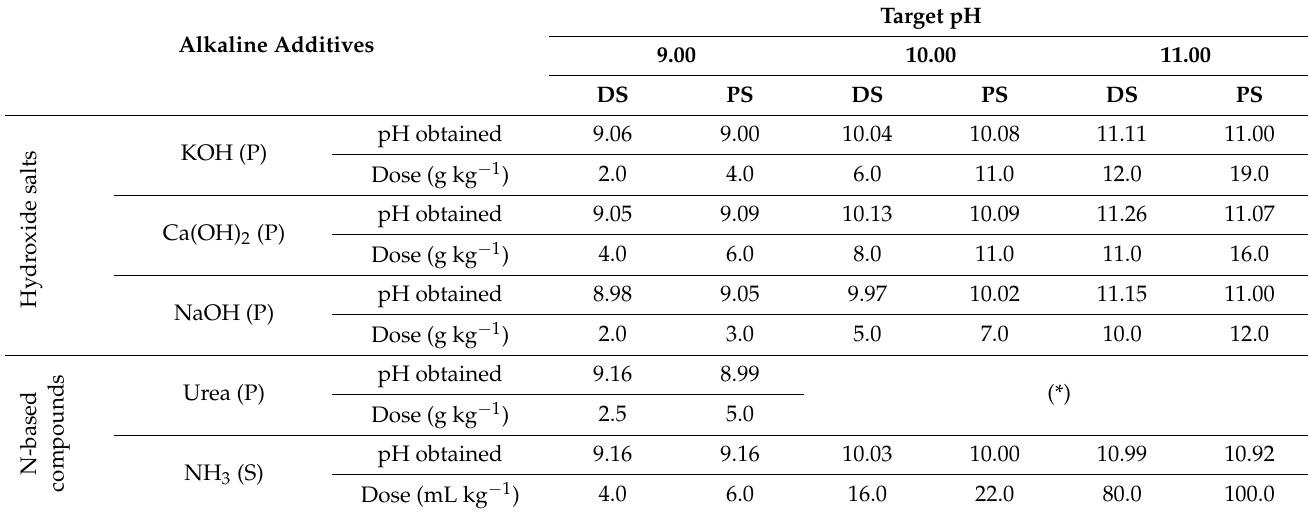
Table 2. Doses of potassium hydroxide (KOH), calcium hydroxide (Ca(OH) 2 ), sodium hydroxide (NaOH), urea ((NH 2 ) 2 CO) (g kg − 1 ), and aqueous ammonia, NH 3 (mL kg − 1 ) necessary to increase the pH of dairy and pig slurries to the target pH values (9.00; 10.00 and 11.00) (Mean, n =